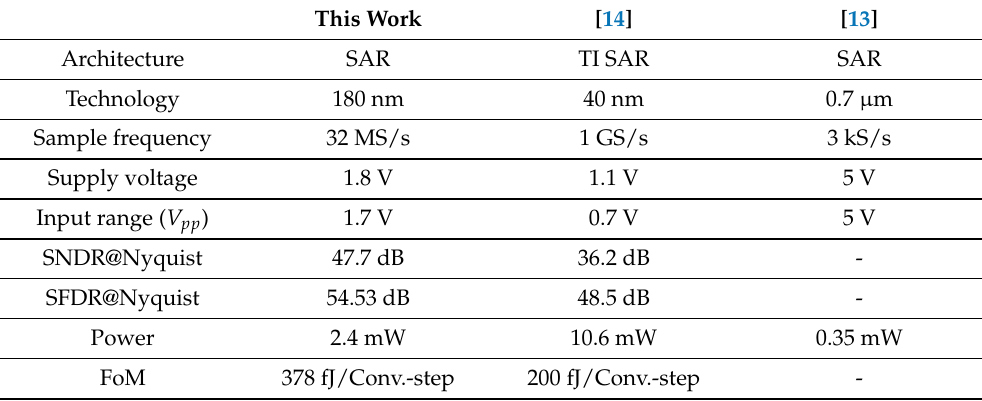
Table 1. Performance summary and